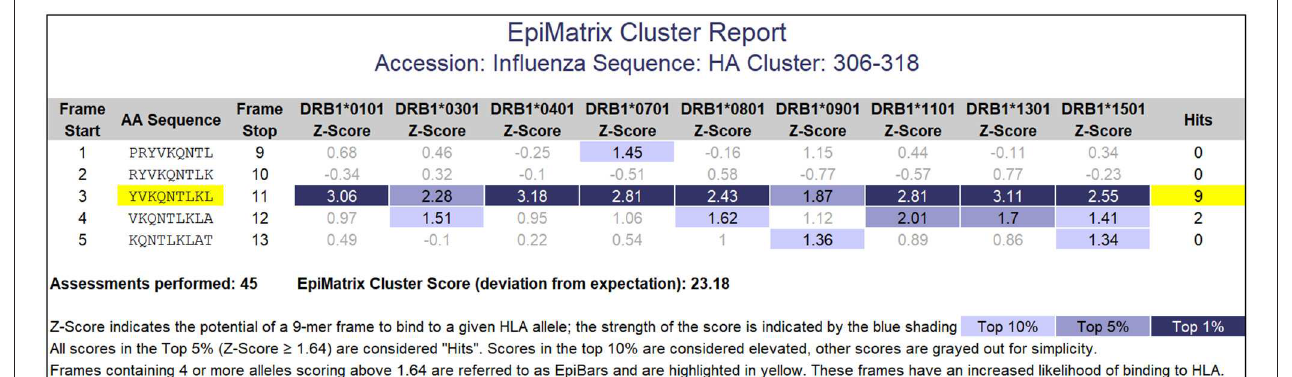
FIGURE 5 | EpiMatrix Class II analysis. This analysis of an influenza hemagglutinin sequence shows a 9-mer frame that contains 7 top 1% hits and 2 top 5% hits for HLA DR alleles. This feature is called an EpiBar (Epitope bar) and is a feature of highly immunogenic epitopes. This analysis was performed using HLA DRB1 alleles.